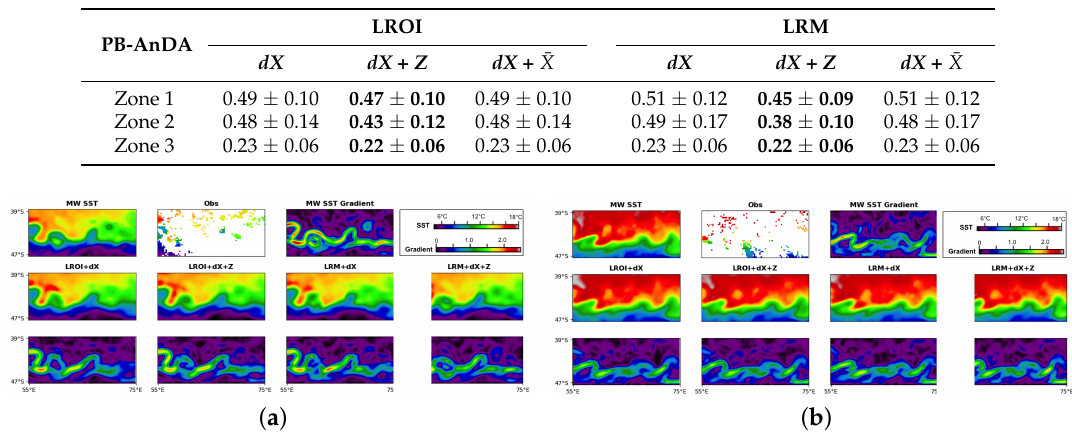
Figure 3. Reconstructed SST fields using OI, DINEOF, G-AnDA, PB-AnDA-LROI + dX + Z , PB-AnDA-LRM + dX + Z on day 150 for MW SST case-study: refer to Figure 1. It may be noticed that only PB-AnDA-LROI + dX + Z and PB-AnDA-LRM + dX + Z retrieves the fine-scale eddy-like structure off South Africa on this particular date. Table 4. Interpolation performance of PB-AnDA models for a 5-daily MW SST case-study for three zones of interest in the case-study region: we refer the reader to the main text for the description of the different PB-AnDA parameterizations.